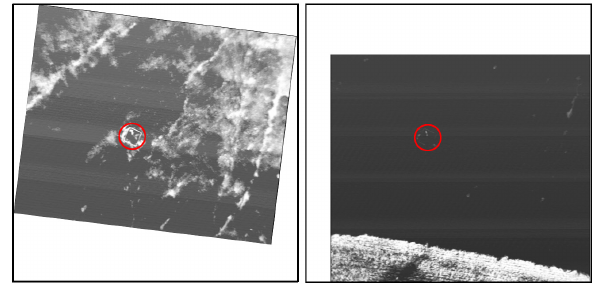
Figure 8: variation of the contrast with the Automatic Gain Control. Flight altitude: 30 m